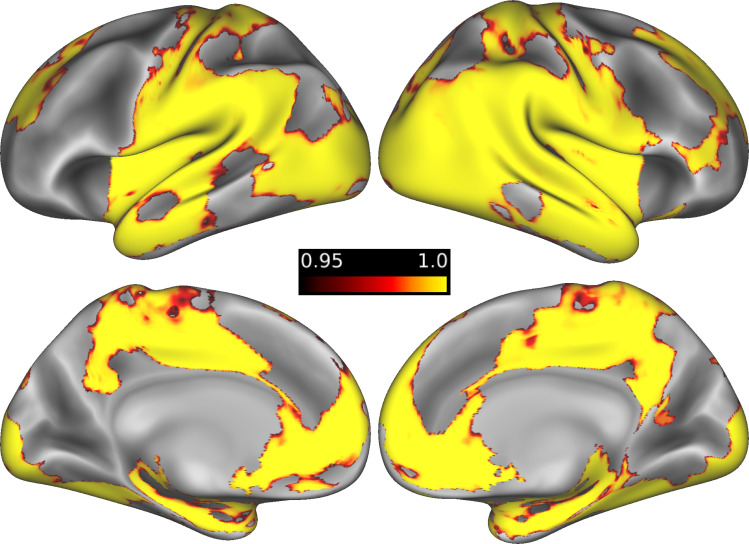
Brain regions showing greater activation for restudy than retrieval practice.Regions showing greater activation during memory updating under the Restudy condition than under the RetPrac condition. Stronger activation was found in the medial prefrontal cortex (MPFC), bilateral hippocampus (HPC), ventral visual regions, medial parietal cortex, and lateral parietal cortex (which extended to the lateral temporal cortex). The color bar indicates one minus the P value (corrected). Please refer to Supplementary file 3b for details.